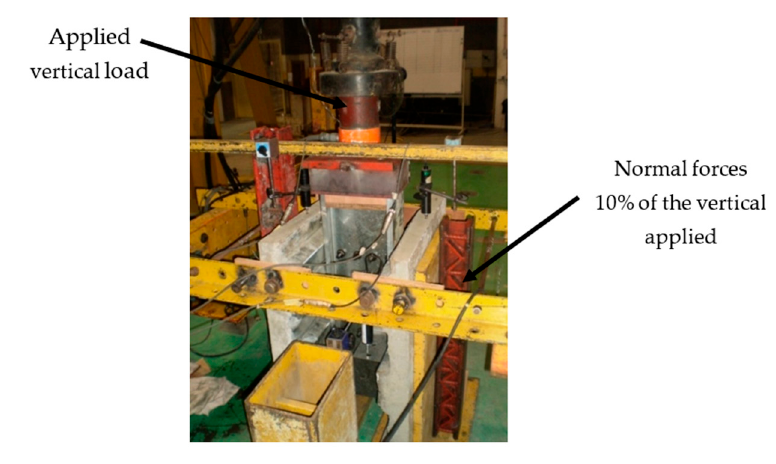
Figure 4. Push test set up [21].